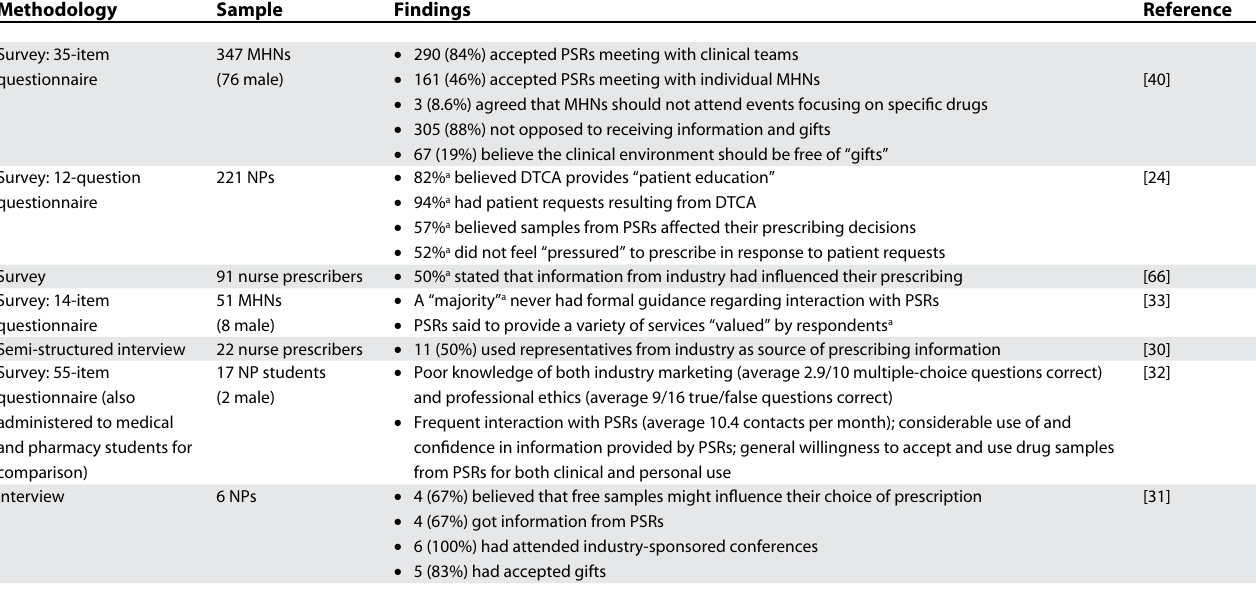
Table 1. Summary of Empirical Findings Regarding Pharmaceutical Industry Influence on Nurses Methodology Sample